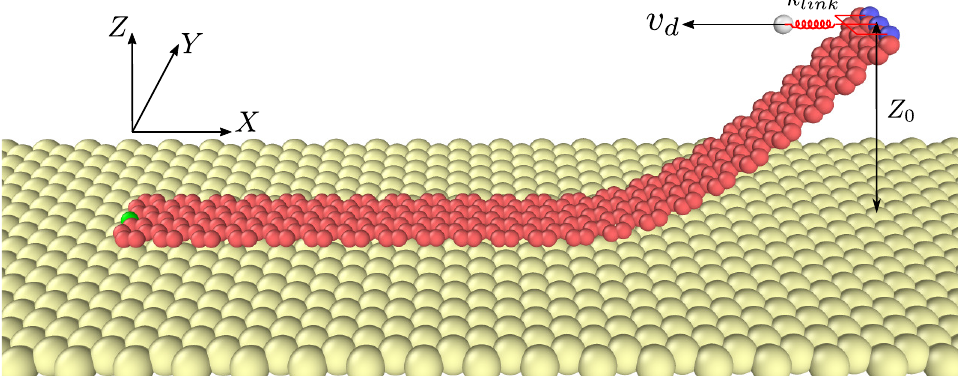
Figure 1. Schematic of the computational model. GNR is horizontally dragged by imposing a speed v d to the virtual atom connecting to the atoms (in blue color) at the lifted side, using a linear spring of stiffness k link = 1.5 N/m. The lifting height Z 0 remains unchanged during the dragging process, and we record the motion of the green